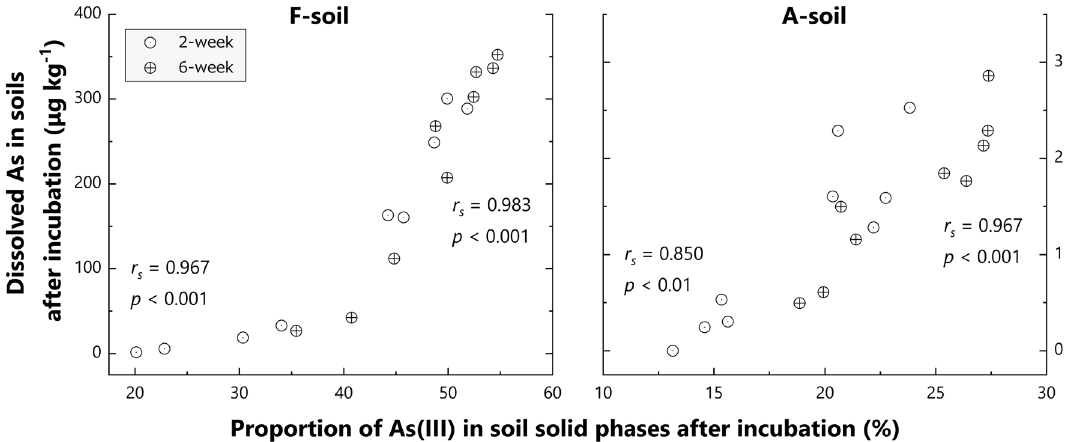
Figure 7. Relationship between dissolved As and As(III) proportion in solid phases of soils with or without selected organic amendments (2, 5, 9, 10, 13, 14, 19 and 23) after 2- and 6-week incubation. Dissolved As is shown as the average of duplicates. r s denotes Spearman’s rank-correlation